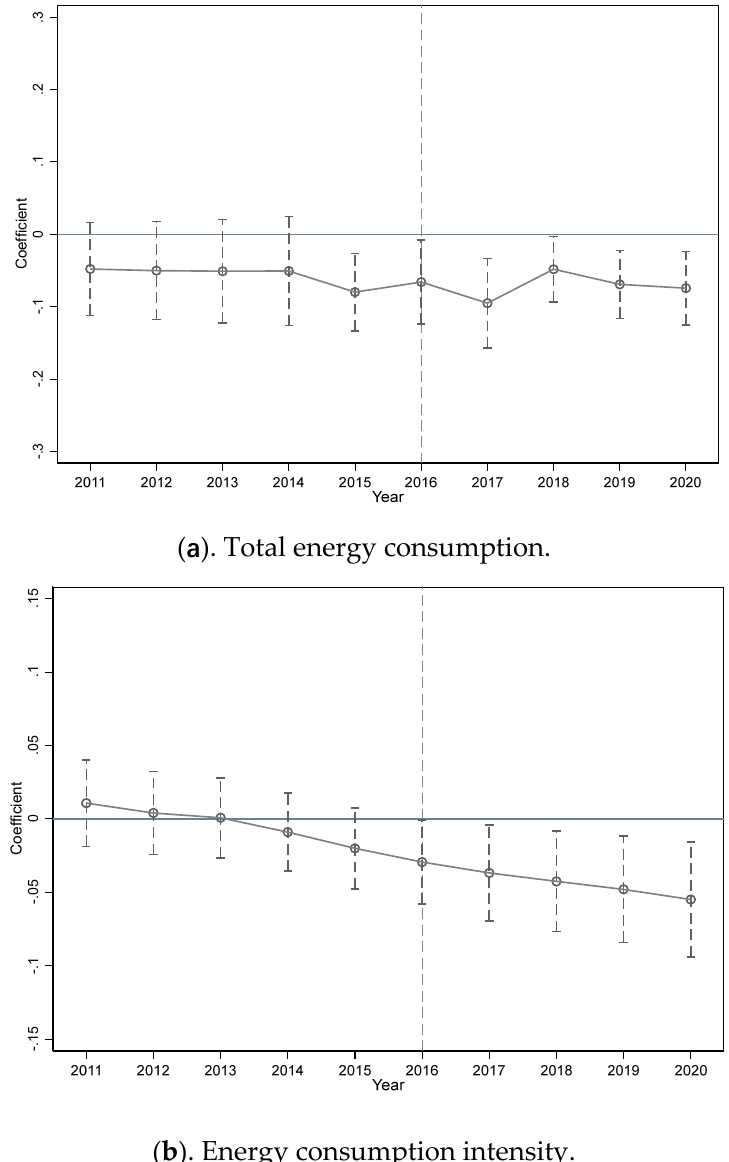
Figure 1. Parallel trends and dynamic effects.